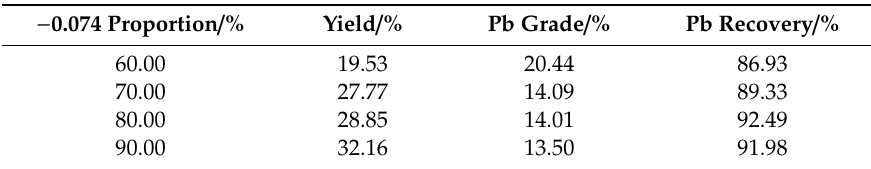
Table 5. Results of grinding fineness tests.